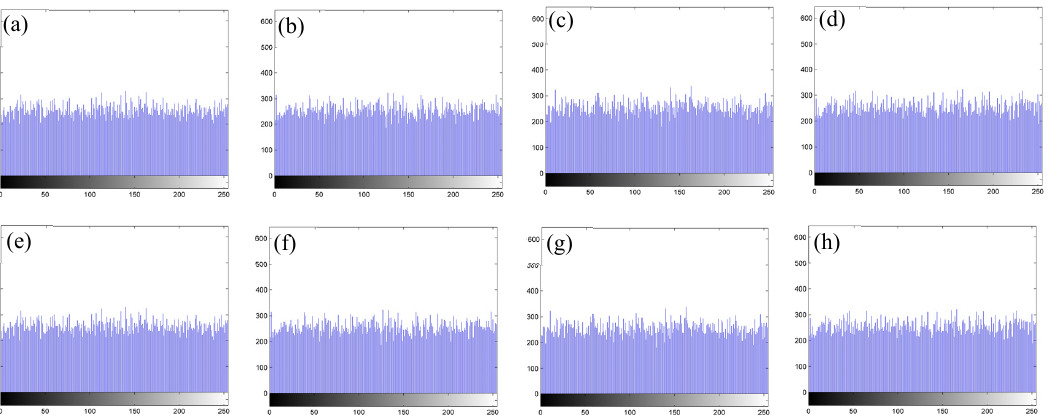
Figure 10. The histograms of the eight ciphertext images. ( a – h ) The histogram distributions of the ciphertext